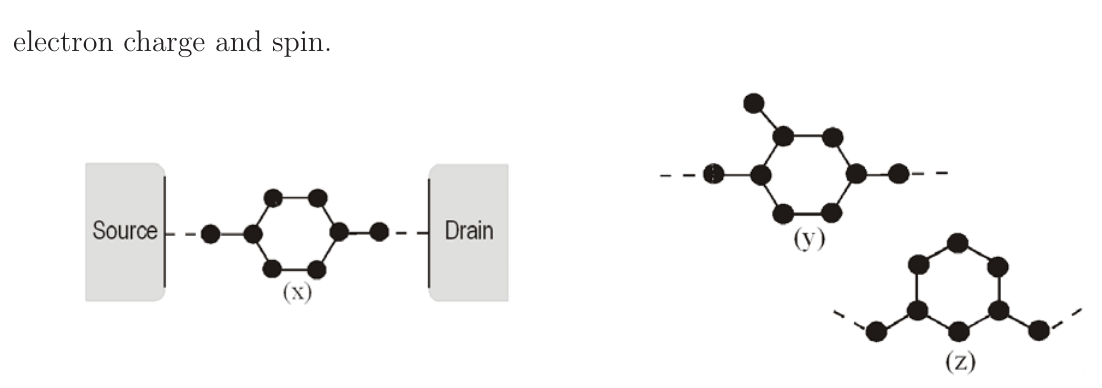
Fig. 1 Schematic representation of a molecular device (two electrodes spanned by various bridges; black circles represent atoms of the